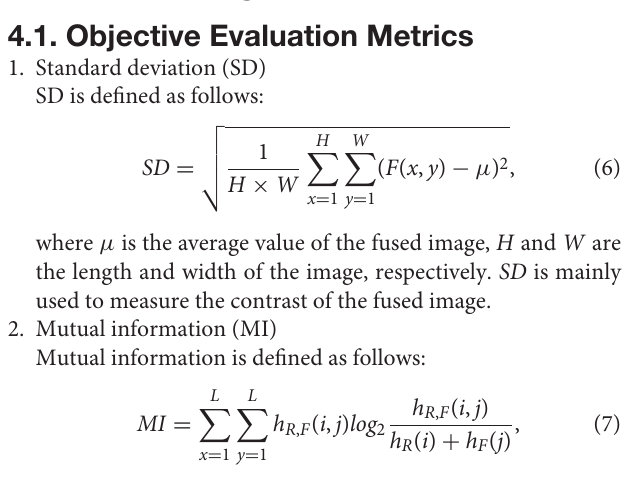
Frontiers in Neurorobotics |